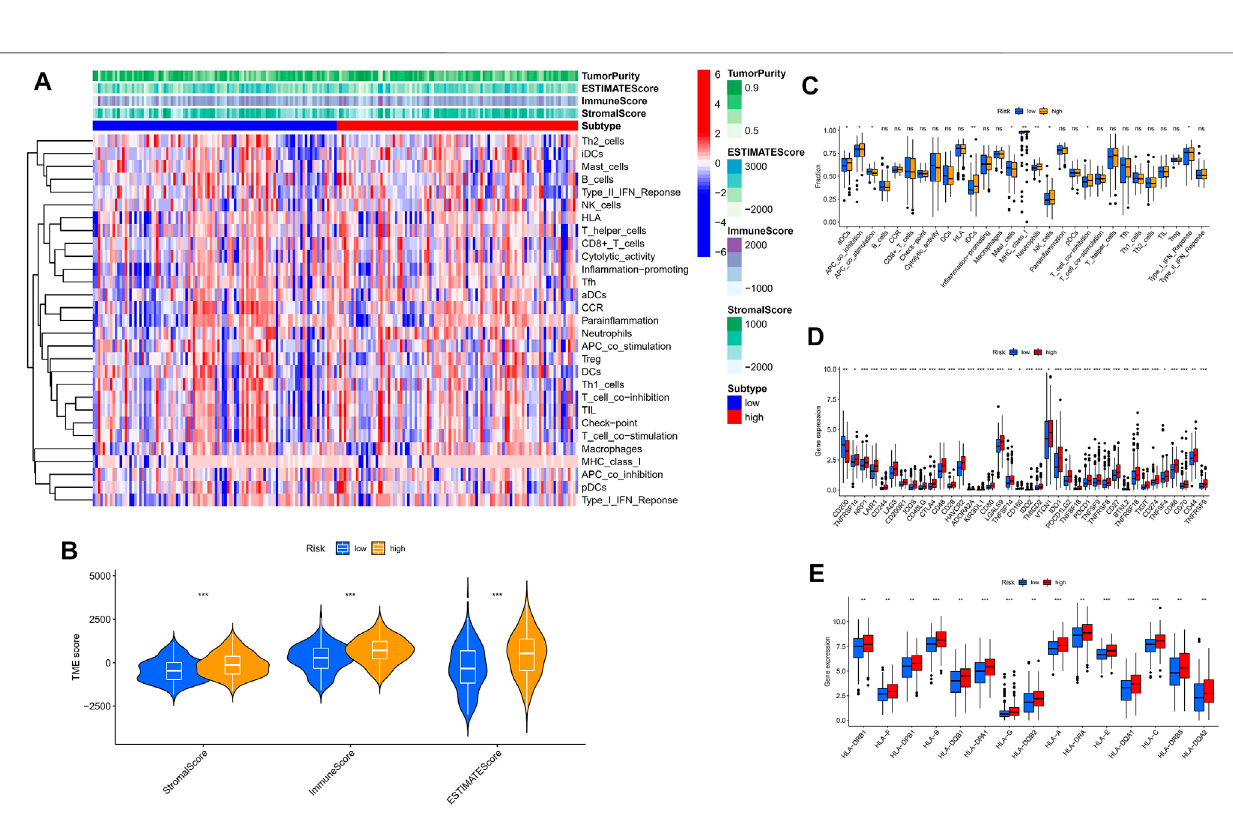
Frontiers in Cell and Developmental Biology |